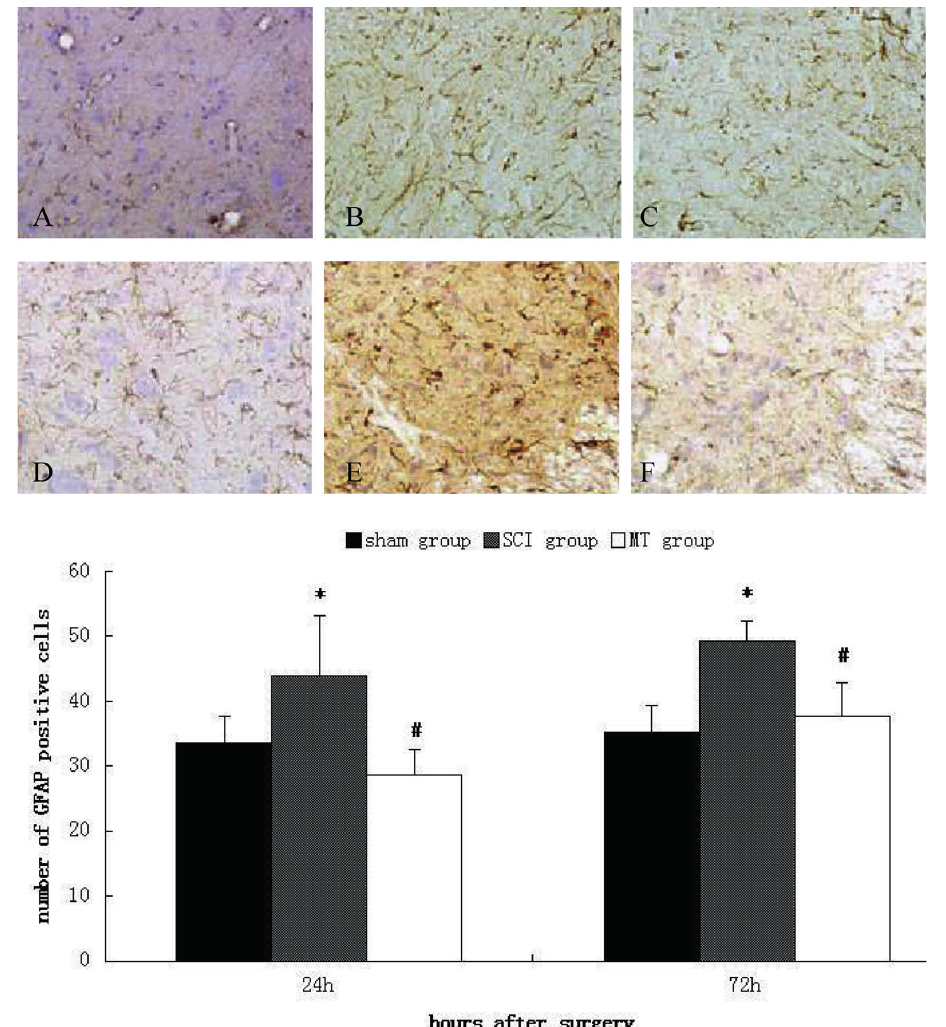
Fig. 4. Changes of GFAP positive cells expression using IHC method at 24 and 72 h after injury (A: 24 h of Sham group, B: 24 h of SCI group, C: 24 h of MT group, D: 72 h of Sham group, E: 72 h of SCI group, and F: 72 h of MT group). The number of GFAP positive cells in gray matter regions in SCI group was significantly up-regulated compared with that of Sham group at 24 and 72 h after injury. The number of GFAP positive cells in MT group was significantly down-regulated compared with that of SCI group at 24 and 72 h after injury. Data present mean ± SD (n=5, * P <0.05 between Sham group and SCI group, # P <0.05 between melatonin group and SCI group, scale bar=50